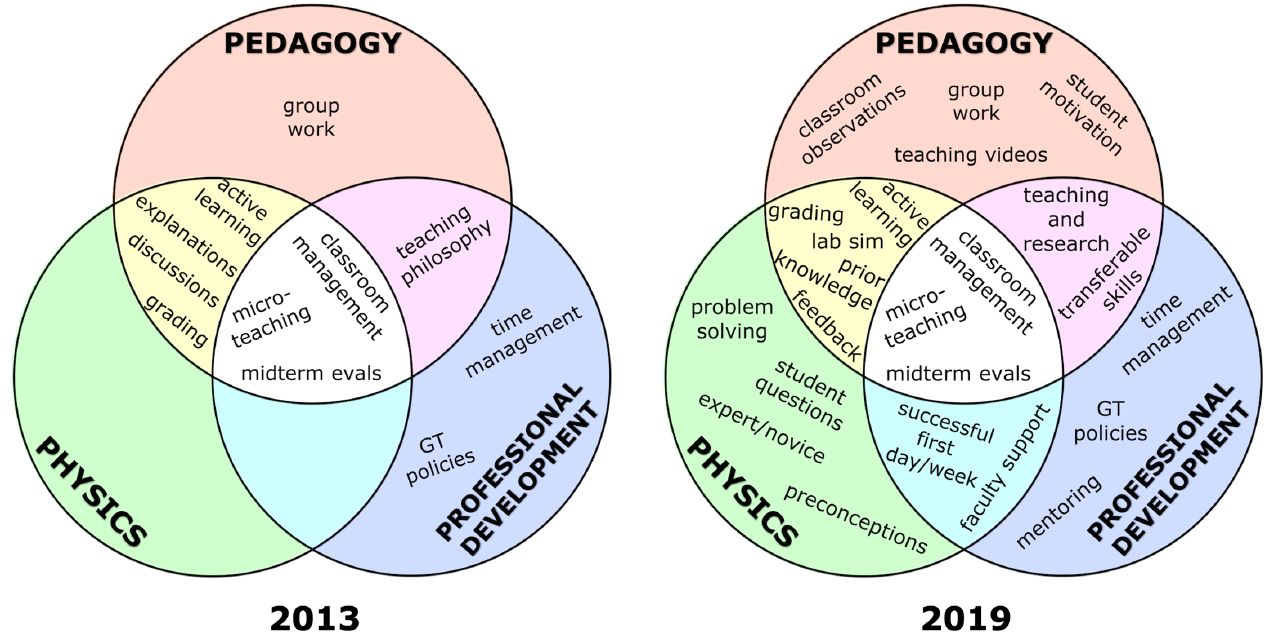
FIG. 3. Mapping the course contents onto the 3P framework. Left panel: the pilot semester (Fall 2013). Right panel: the most recent in- person semester (Fall 2019). Note that the gaps present at the beginning are now